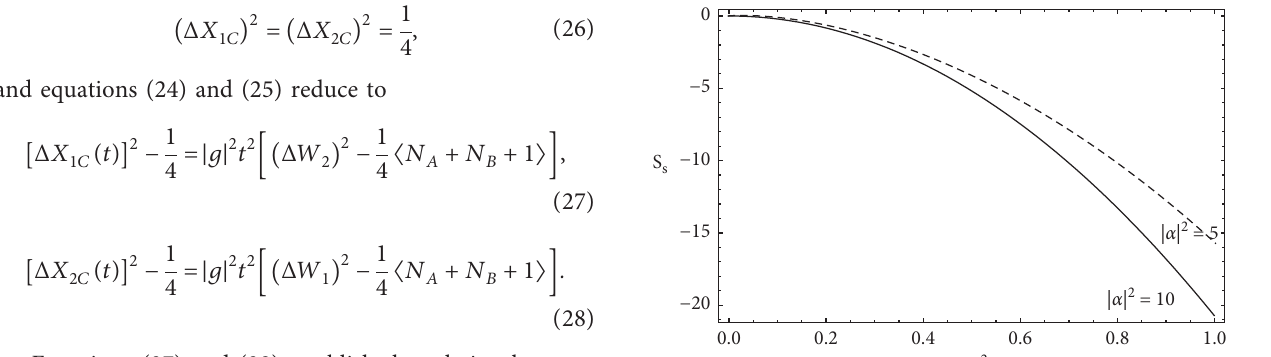
2 in the S with | gt |